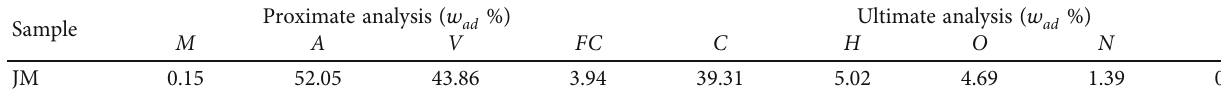
Table 1: The proximate analysis and ultimate analysis of JM.